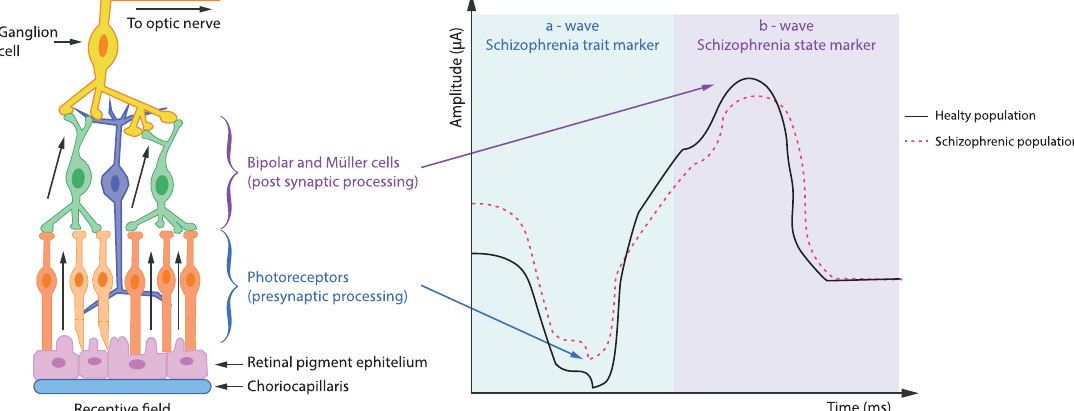
Fig. 2 Schema of ERG signal from retinal cells. An illustration of the retina (left) and a representative ERG comparing HCs and schizophrenia patients (right). In the dark-adapted retina, a light stimulus elicits a presynaptic response from photoreceptor cells, represented by the downward-de fl ecting a-wave. The subsequent postsynaptic response, mediated largely by bipolar and Müller cells, produces the b-wave. The a-wave amplitude (measured from the baseline to the trough of the a-wave) depends on the intensity of the light stimulus and the integrity of the photoreceptors. The b-wave amplitude (measured from the trough of the a-wave to the peak of the b-wave) depends on the a-wave and the integrity of signal transmission within the retina. Redrawn from Hanjin Deivasse web illustration.